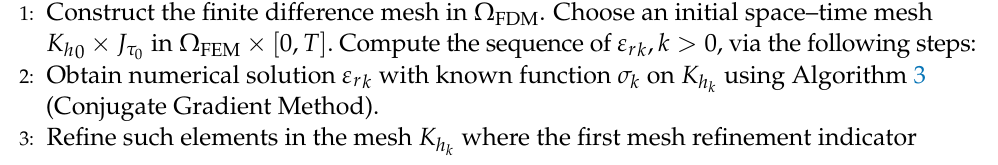
Algorithm 4: Adaptive Algorithm, first version.